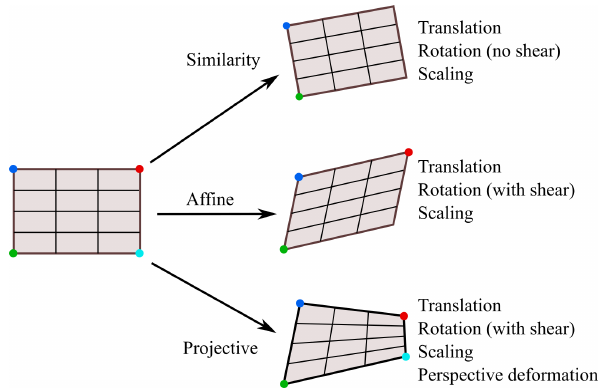
Figure 3. Examples of image transformation